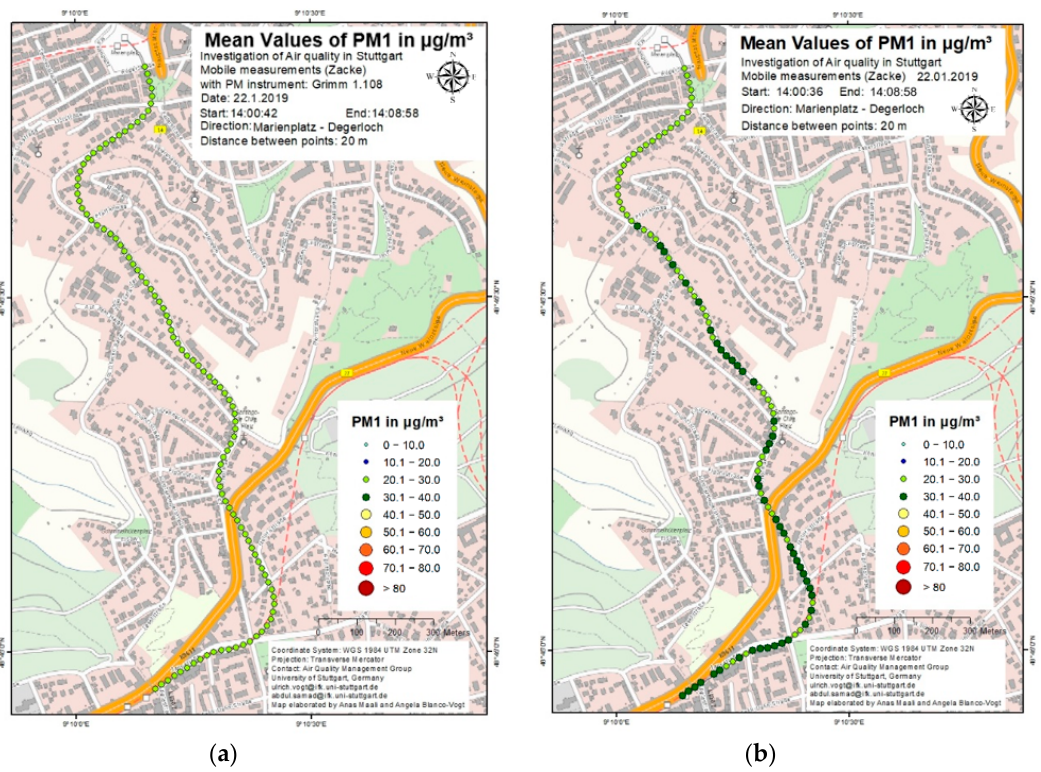
Figure 14. PM1 concentration using ( a ) mobile aerosol spectrometer ( b ) sensor-monitoring box.